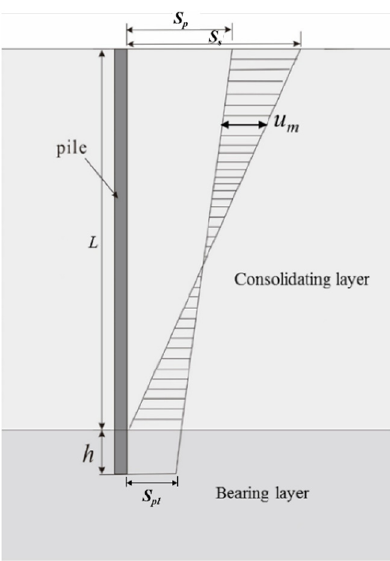
Figure 1. The relative settlement of pile soil.